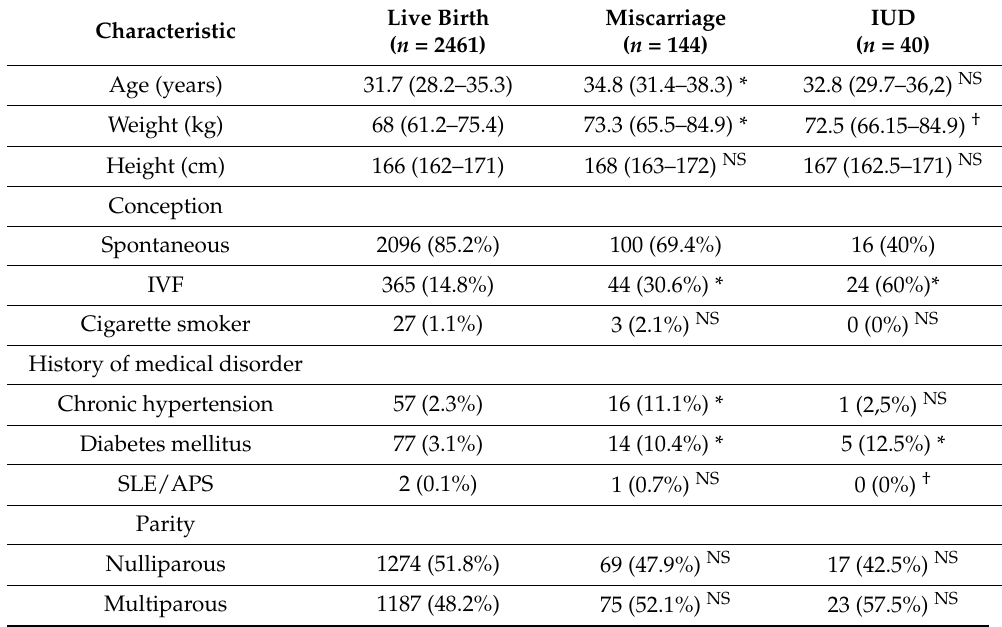
Table 2. Comparison of maternal characteristics according to the occurrence of miscarriage and